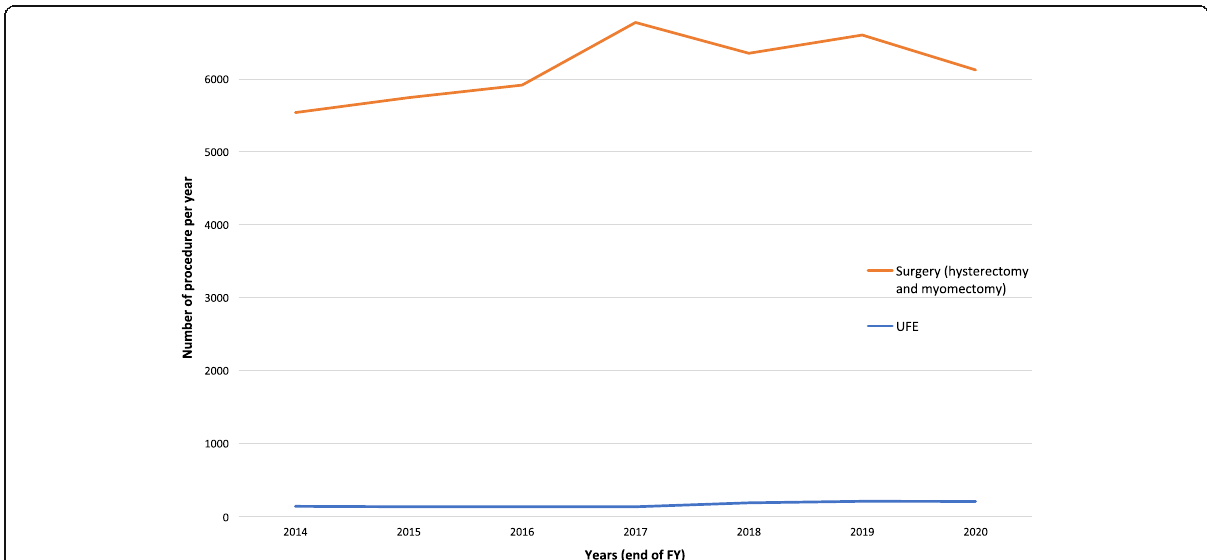
Fig. 1 Graph comparing the estimated number of uterine surgeries for fibroid disease, compared to the number of uterine fibroid embolisation procedures, each financial year in Australia. Data is extrapolated from Medicare item codes 35,410, 35,649, 35,638, 35,653, 35,661, 35,657, 35,753, 35,754, and 35,756, for the financial years 2013/14 to